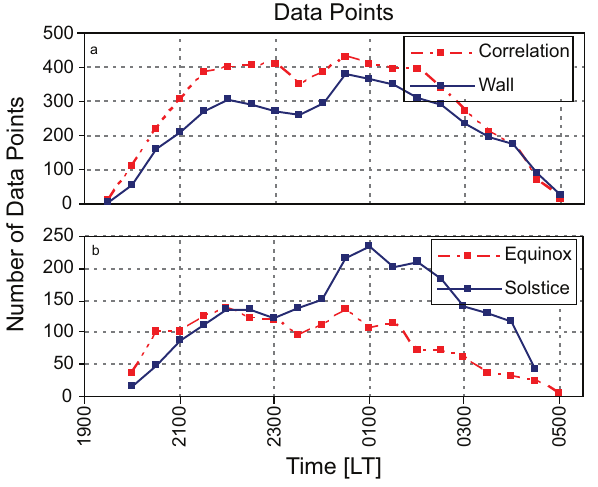
Fig. 1. (a) Total number of data points available in each time bin. The west wall tracking routine contains fewer data due to a number of images with ill-defined intensity gradients which were thrown out from the analysis. (b) Number of data points used by the wall tracking routine in each time bin for the equinox and June solstice seasons.